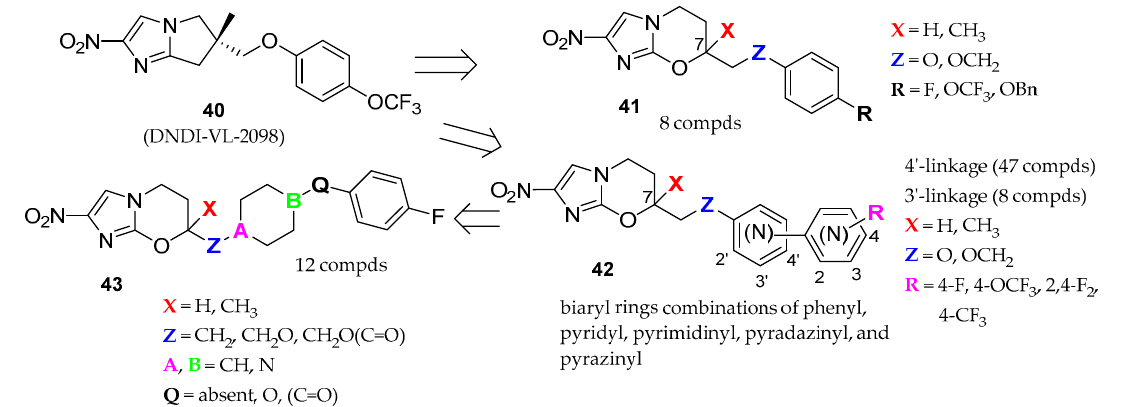
Molecules 2020 , 25 , x FOR PEER REVIEW 5 of Figure 11. Genus of analogues 41 – 43 for treatment of visceral leishmaniasis. Figure 11. Genus of analogues 41 – 43 for treatment of visceral leishmaniasis.